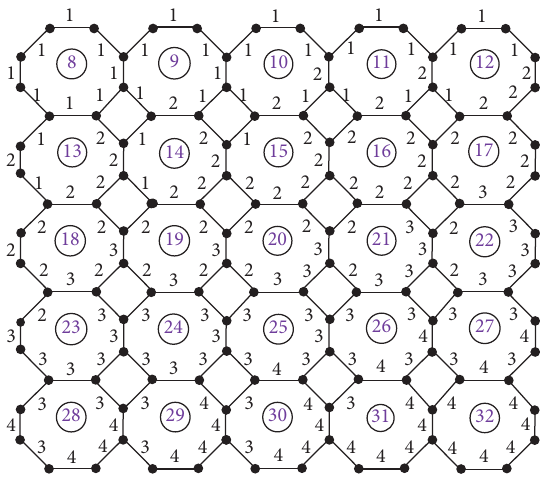
Figure 4: Labeling and weights of octagonal grid graph O 5